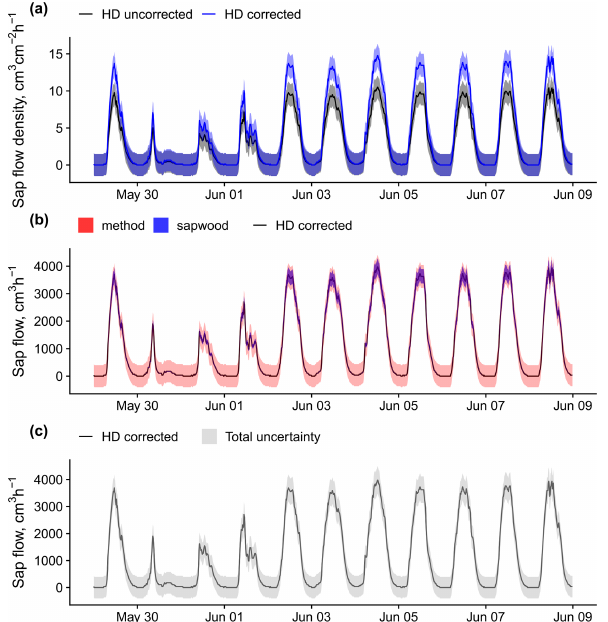
Figure B3. An example of sap flow uncertainty estimation and bias correction for a Pinus sylvestris tree (ESP_VAL_SOR_Js_Ps_12) measured using heat dissipation sensors. Panel (a) shows sap flow density HD measurements with and without the application of the bias correction reported in Flo et al. (2019), together with the corresponding uncertainty estimated from the model in Fig. B1. Panel (b) shows corrected sap flow data comparing methodolog- ical uncertainty with that derived from the 68% predictive inter- val of sapwood area estimation. Panel (c) shows corrected sap flow data together with the combined methodological and sapwood un- certainty.